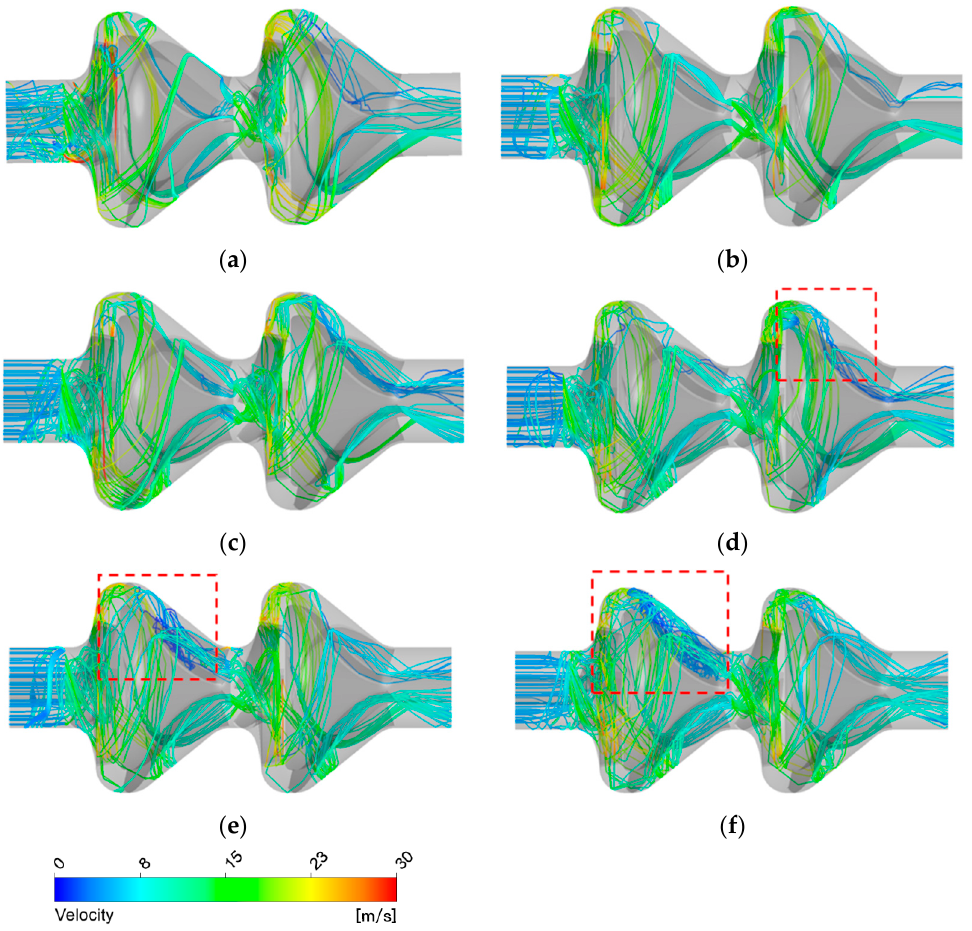
Figure 5. Particle movement trajectories in the calculation domain: ( a ) d p = 3 mm; ( b ) d p = 6 mm; ( c ) d p = 10 mm; ( d ) d p = 14 mm; ( e ) d p = 17 mm; ( f ) d p = 20 mm.